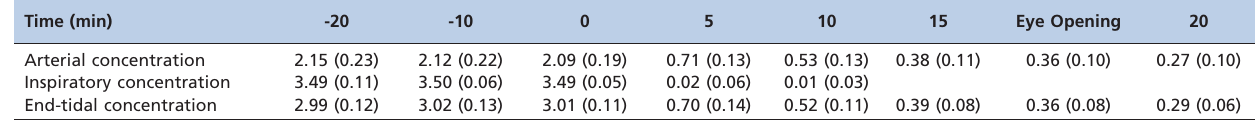
Values are presented as the mean (SD). The mean time to eye opening was 15.8 (2.9) min. The time point 0 min was immediately prior to the discontinuation of 3.5% sevoflurane.